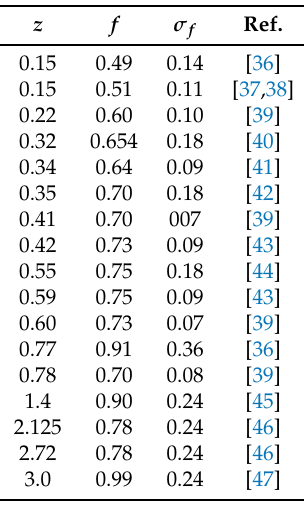
Table 1. Currently available data for growth rates used here.